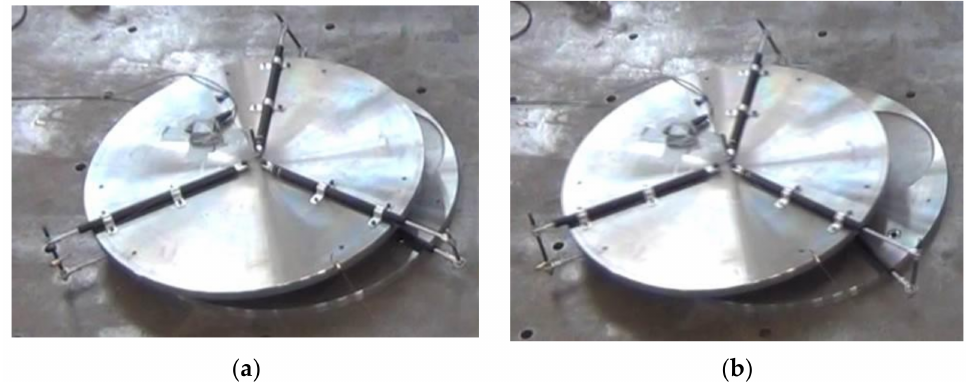
Figure 20. Maximum displacement response of the same device under ChiChi-TCU084 ground motion with ( a ) PGA = 1.4 m/s 2 and ( b ) PGA = 4 m/s 2